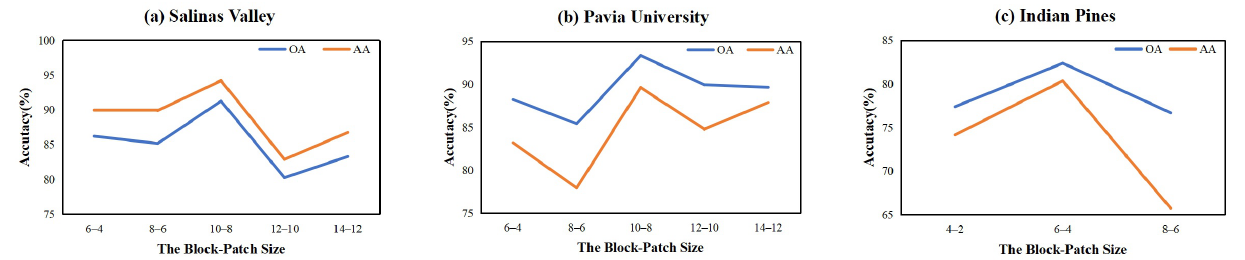
Figure 11. Effects of the block-patch size on OA and AA (%): ( a ) Salinas Valley, ( b ) Pavia University, and ( c ) Indian Pines.